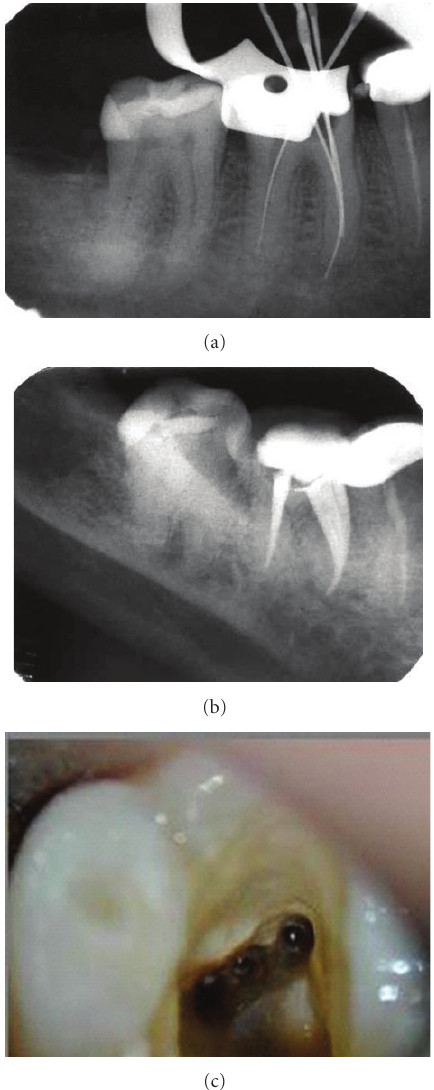
Figure 4: (a) Working length. (b) Obturation. (c) Clinical